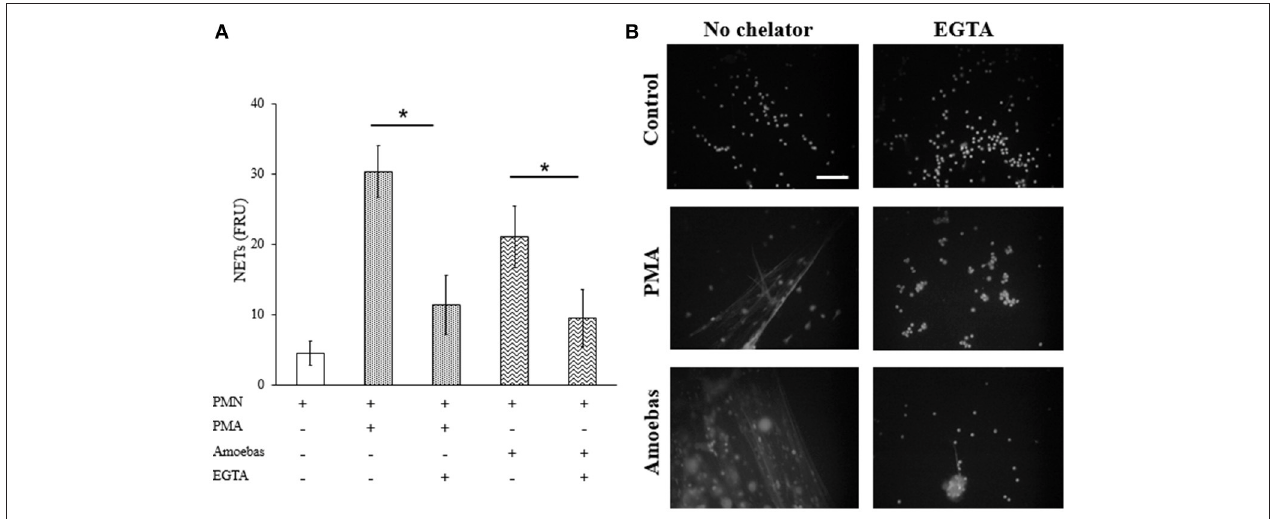
FIGURE 11 | NETosis induced by E. histolytica trophozoites require the presence of extracellular calcium. (A) Neutrophils (3 × 10 5 ) were culture in the presence or absence of 20mM EGTA. EGTA-treated neutrophils were stimulated with 20nM PMA or co-cultured with trophozoites (1.5 × 10 4 ) during 4h. Supernatants were collected, mixed 1:1 with SYTOX Green (500nM) and fluorescence was measured. NETs amount is expressed in fluorescence relative units (FRU). Values are means ± SD of three independent experiments in triplicate. * p < 0.001. (B) Neutrophils were treated as describe previously, fixed and stained with DAPI. Images were taken at 60x magnification. Scale bar 50 µ m.